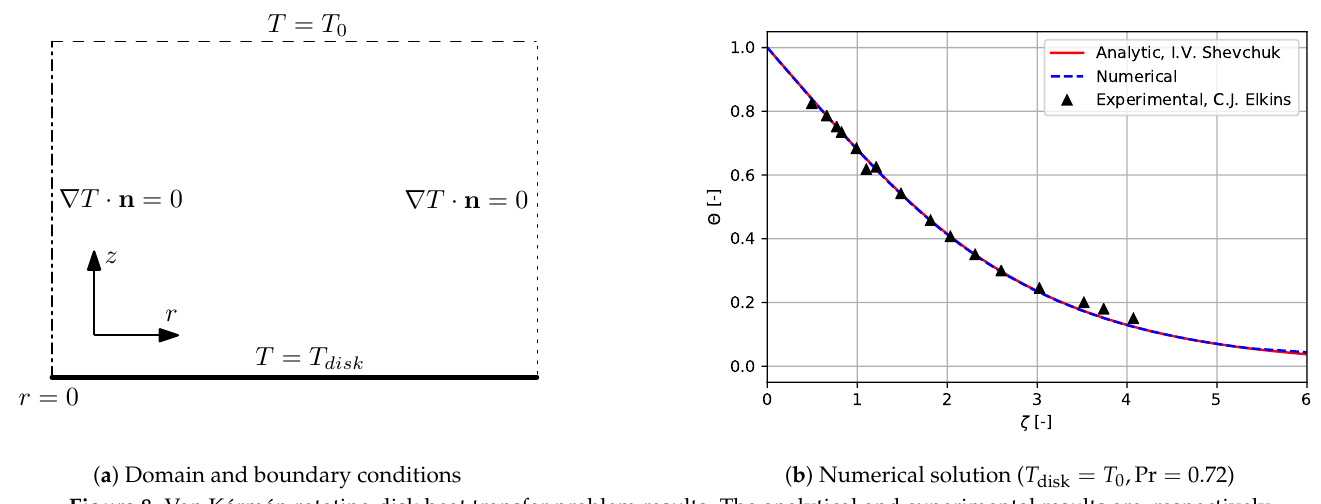
Figure 8. Von Kármán rotating disk heat transfer problem results. The analytical and experimental results are, respectively, determined by Shevchuk [61] and Elkins [62], while the data have been provided by [10].